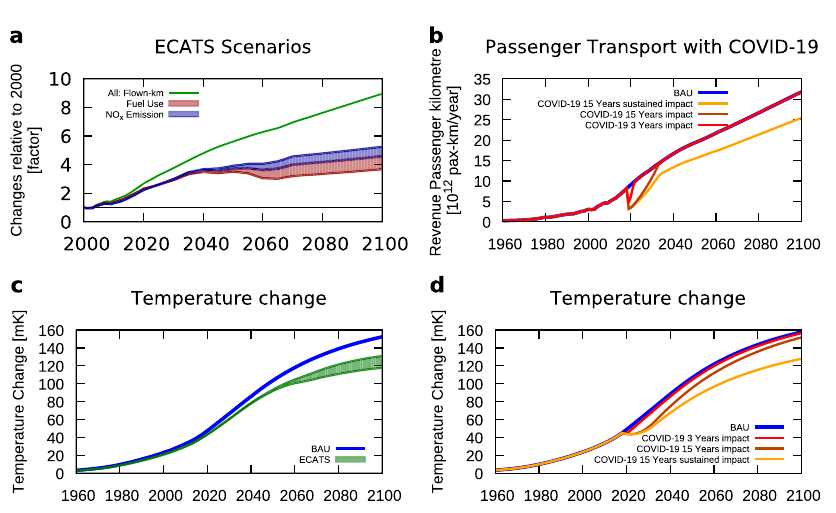
Fig. 5 Expert judgement of feasible future technology developments (left) and the impact from the COVID-19 pandemic (right). a as in Fig. 1, changes in fuel use (red) and NO x emissions (blue) taking into account a bottom-up analysis of aviation technologies; three far future technology pathways are taken into account, with a ± 10% uncertainty range, each leading to a scenario range; b Transport volume for the scenario taking into account a reduction of fl ight due to COVID-19 with three assumptions: a short recovery of 3 years (red); a longer recovery of 15 years (brown) and in addition to a long recovery a behavioural change after COVID-19 (yellow). c Resulting temperature changes as in Fig. 2 for the range of ECATS scenarios (green) and the BAU scenario for comparison (blue). d Resulting temperature changes from the 3 COVID-19 scenarios (red, brown, and yellow) in comparison to the BAU scenario (blue). The scenario BAU describes a business-as-usual future technological improvement and ECATS bottom-up estimates based on a group of experts from ECATS (Environmentally Compatible Air Transportation System).